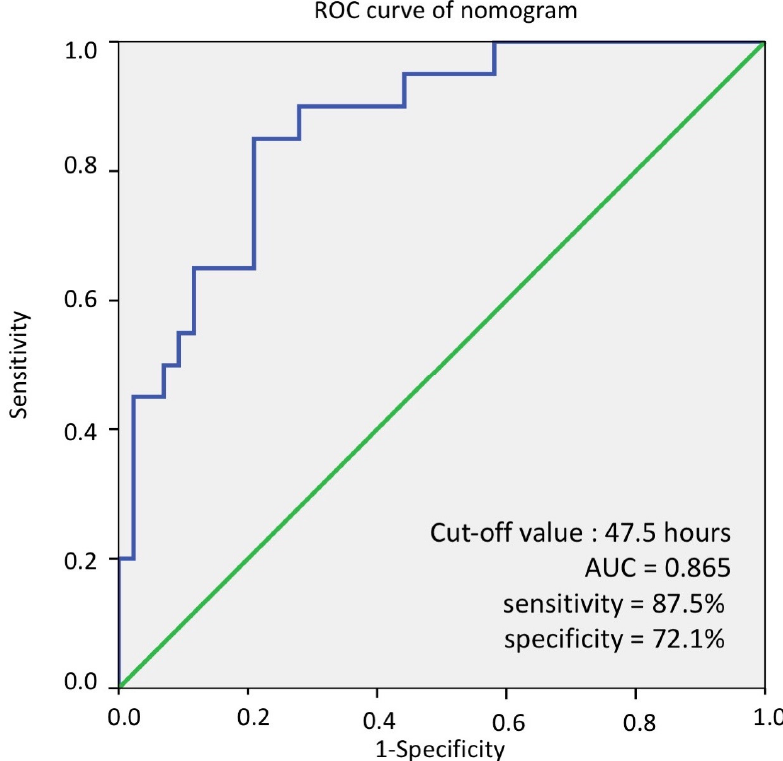
Figure 4. The ROC curve of nomogram for predicting response of RFA. The optimal cut-off value of HLs of DCP for predicting complete radiologic response of RFA was 47.5 h (AUC = 0.865), with a sensitivity of 87.5% and a specificity of 72.1%. ROC curve, receiver operating characteristic curve; RFA, radiofrequency ablation therapies; HL, half-life; DCP, Des-gamma-carboxy prothrombin; AUC, area under ROC curve. Table 2. Difference in DCP half-life between complete and incomplete response RFA patients by standard image modality.